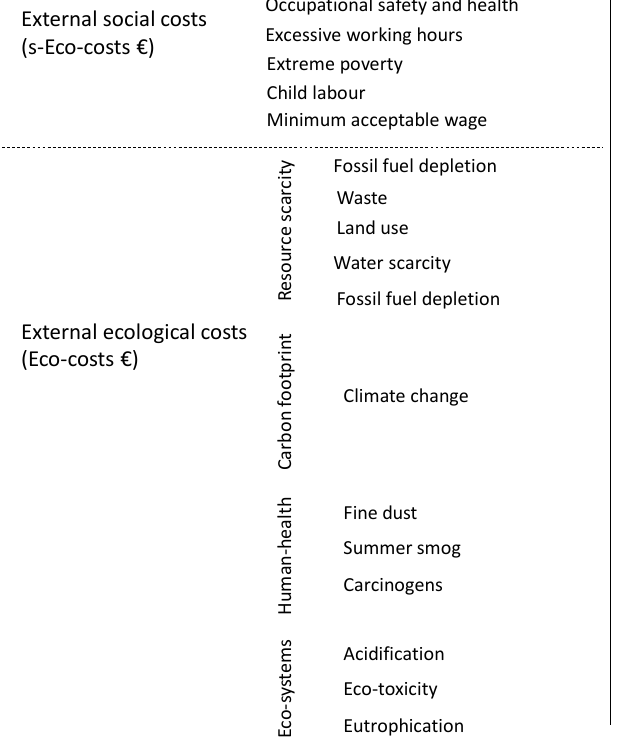
Figure 5. The eco-cost method (environmental and social aspects combined, e-LCA and s-LCA), established in 2012 and last updated in 2017 (version 1.6, updated each 5 year period) [40].